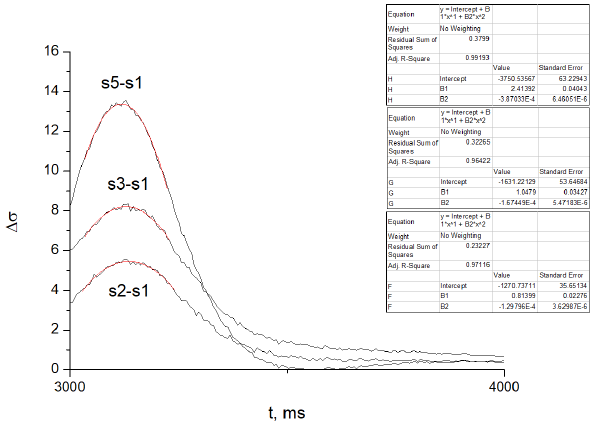
Figure 3. Change in conductivity over time for a semiconductor SmS- based sensor at specified gasoline concentrations.